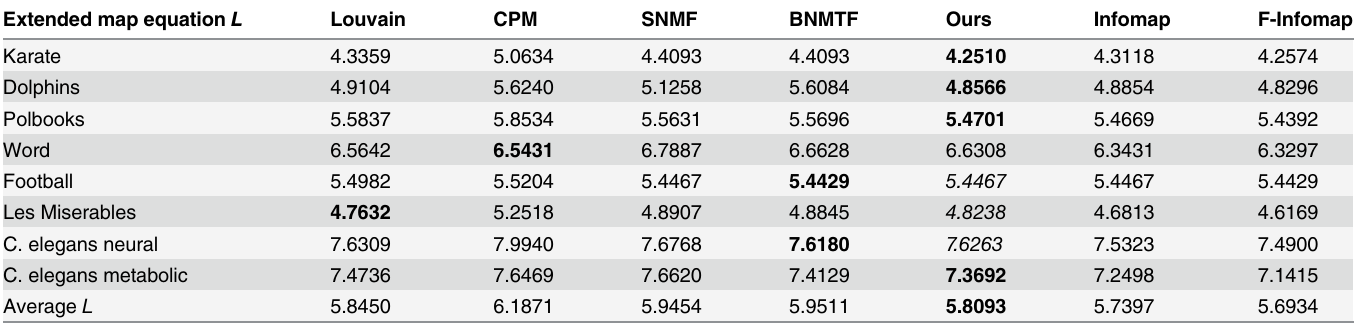
Table 4. Comparison with other methods in terms of the map equation L for overlapping communities (Note that we mark the best results by bold- face and our second best results by italic ). Extended map equation L Karate